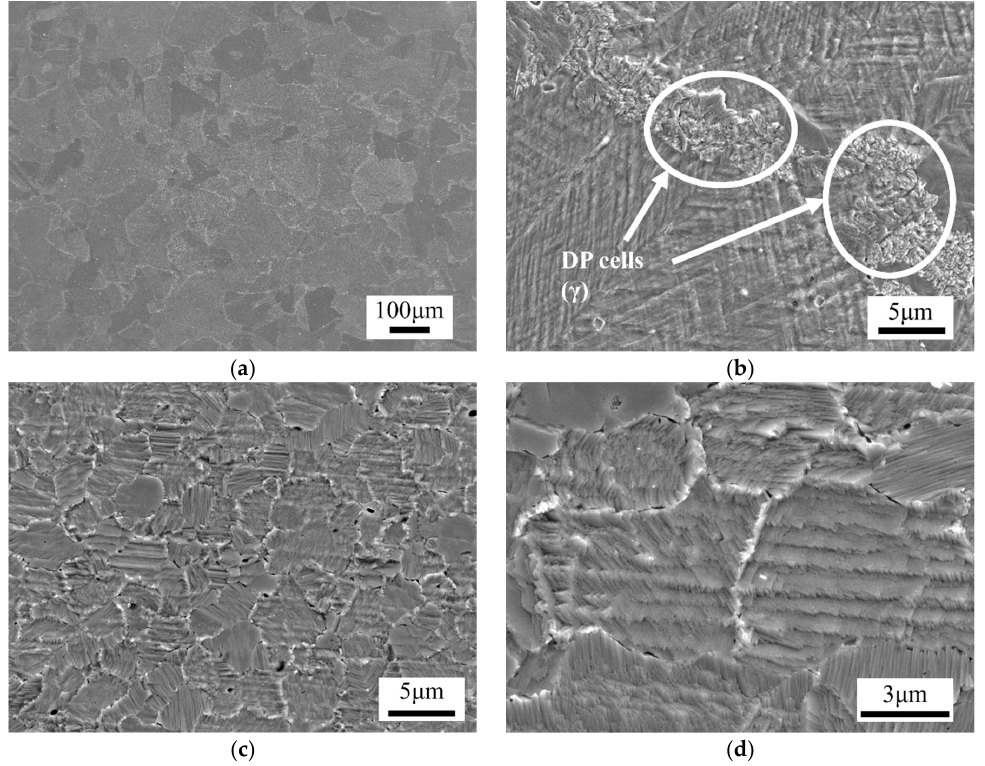
Figure 7. Scanning electron microscope (SEM) Images of the base metal: ( a ) 100 × , ( b ) 3000 × and stir zone ( c ) 3000 × , and ( d ) 7000 × .